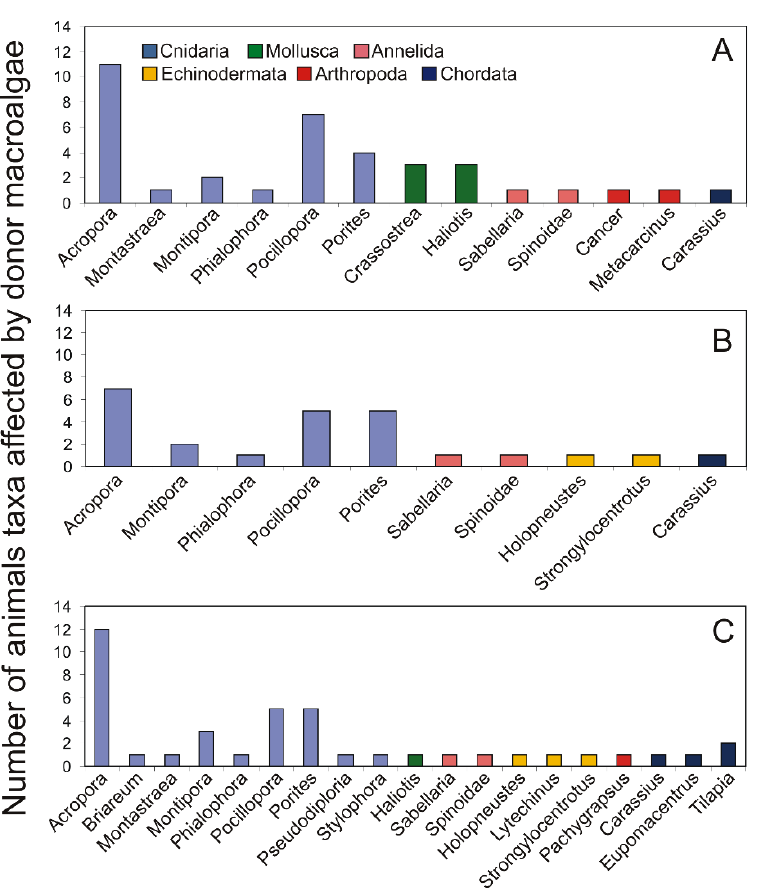
Figure 4. Number of target competitors and herbivores affected by green algae ( A ), red algae ( B ), and brown algae ( C ), based on taxa found in the literature.